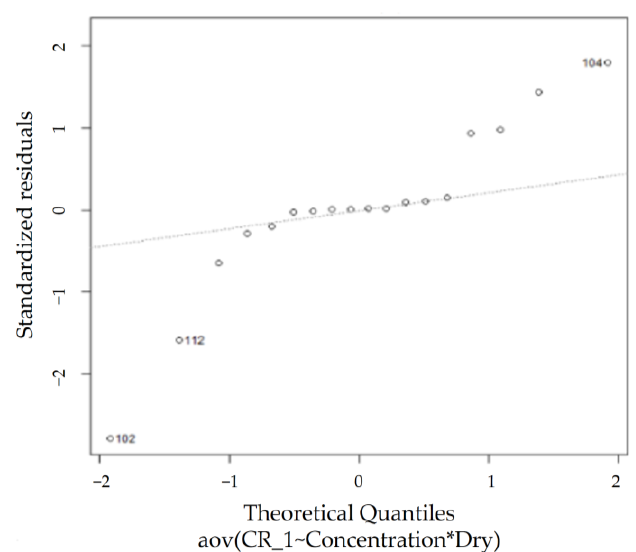
Figure 18. JIS normal QQ plot. Table 8. Shapiro and Levene’s test result